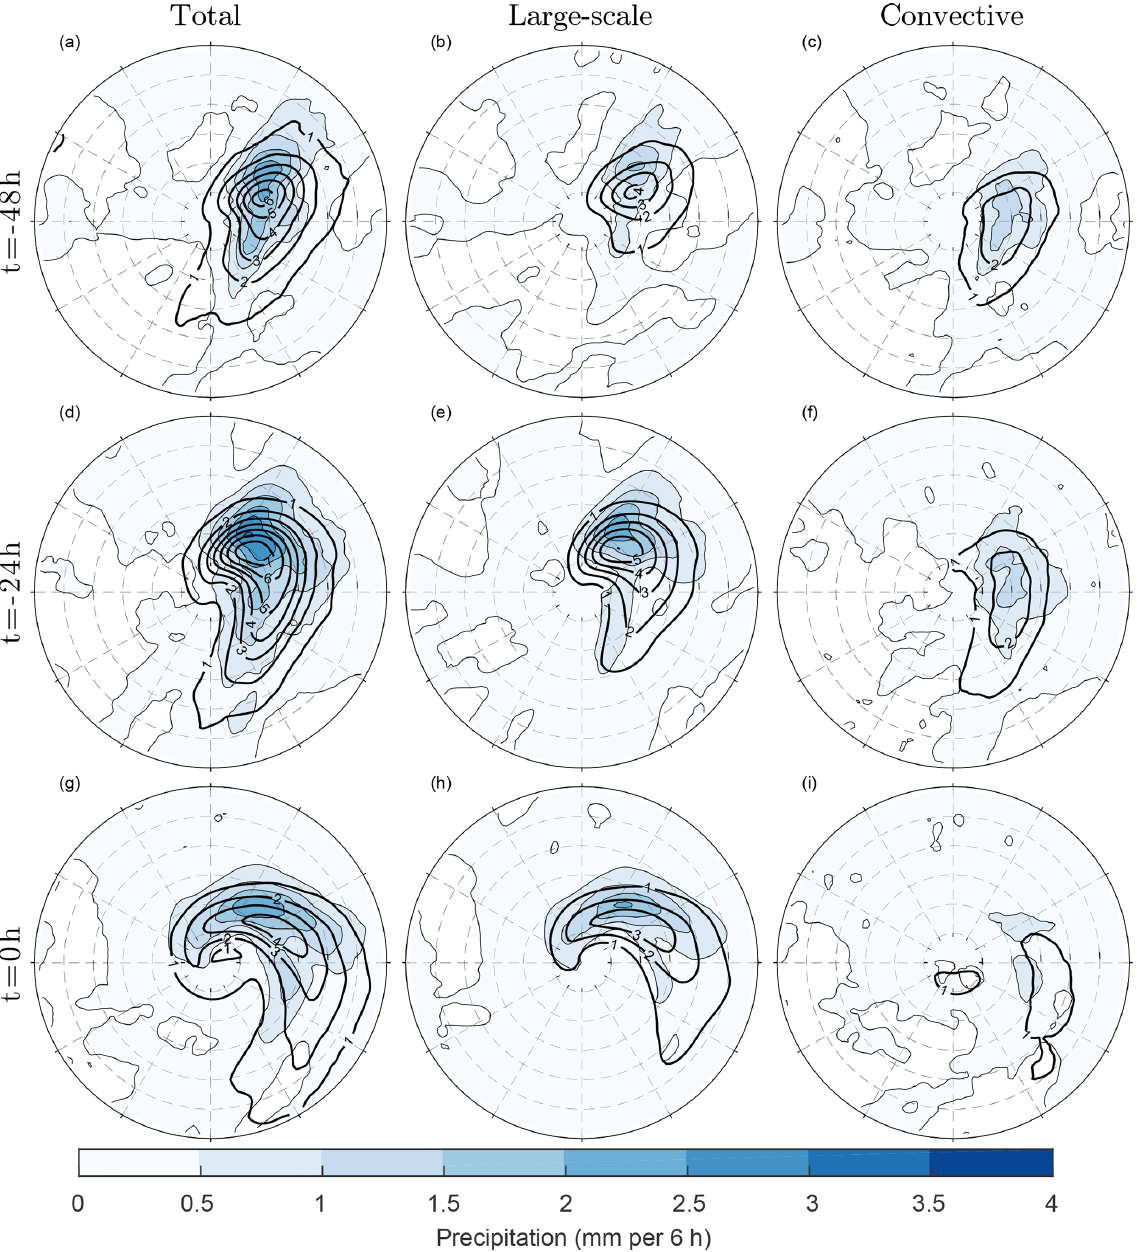
Figure 9. Composites of total precipitation (a, d, g) , large-scale precipitation (b, e, h) , and convective precipitation (c, f, i) in the CNTL simulation (black contours) and the difference between SST4 and control (shading). Panels (a) – (c) are valid 48h before the time of maximum intensity, panels (d) – (f) are valid 24h before the time of maximum intensity, and panels (g) – (i) are valid at the time of maximum intensity. All composites are of the strongest 200 extra-tropical cyclones in each